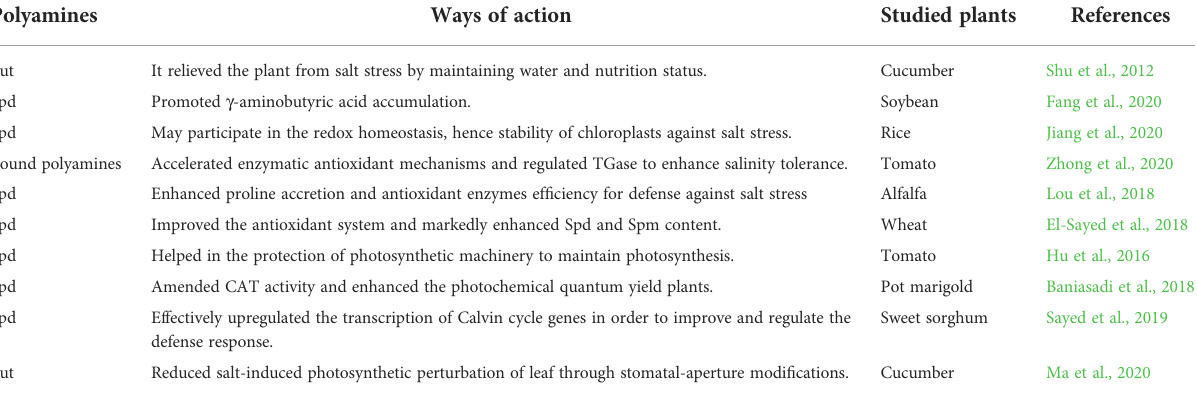
TABLE 2 Exogenously applied polyamines induce salinity stress tolerance in different plant